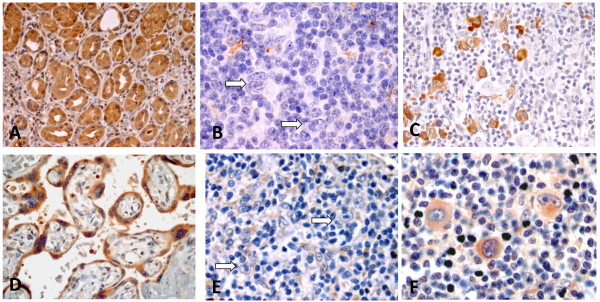
Immunohistochemical expression of ABC proteins in positive controls and CHL tumors.A. ABCC1 is expressed by gastric glands (positive control). B. CHL with negative expression of ABCC1 by HRS cells; scattered histiocytes are weakly positive. C. CHL with HRS cells positive for cytoplasmic expression of ABCC1. D. Placenta with ABCG2 expression in trophoblastic cells (positive control). E. CHL with HRS cells negative for ABCG2; endothelial cells and scattered inflammatory cells are positive. F. CHL with HRS cells positive for cytoplasmic expression of ABCG2.